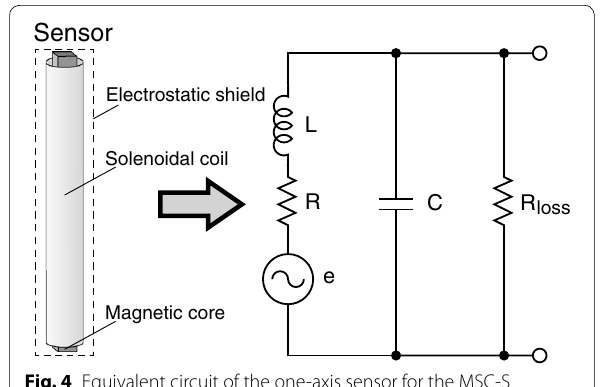
Fig. 4 Equivalent circuit of the one-axis sensor for the MSC-S